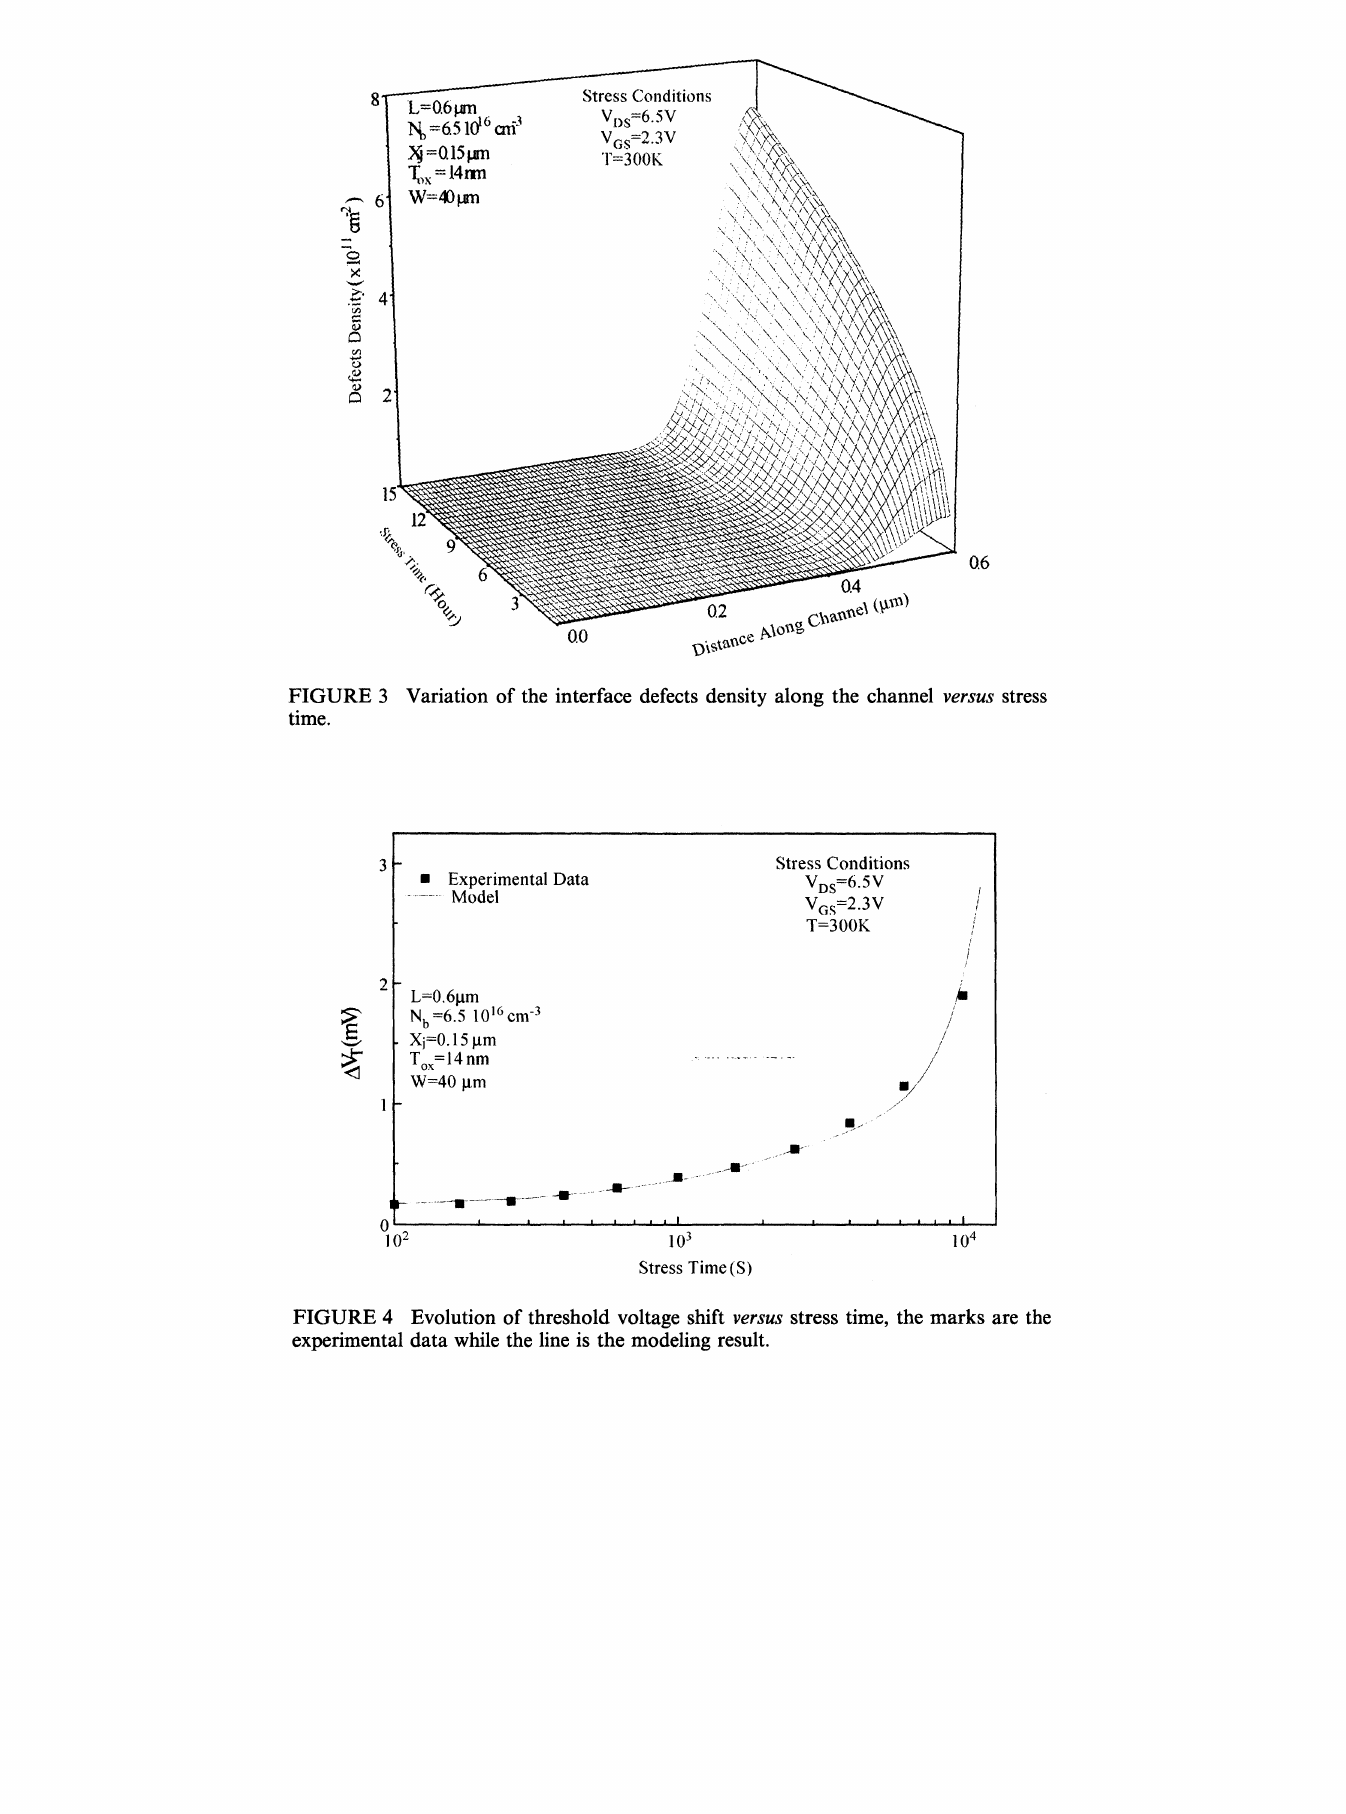
FIGURE 4 Evolution of threshold voltage shift versus stress time, the marks are the experimental data while the line is the modeling